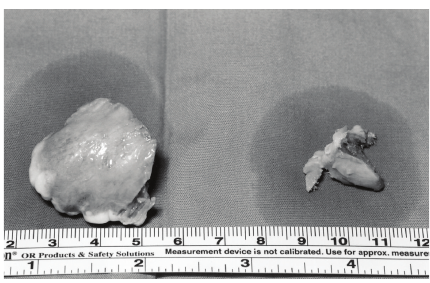
Figure 3: The two spurs that were removed from the anterior